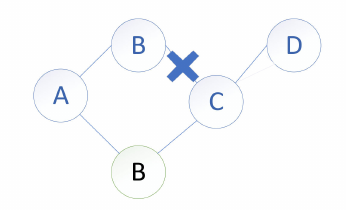
Figure 5. Artificial redundant node